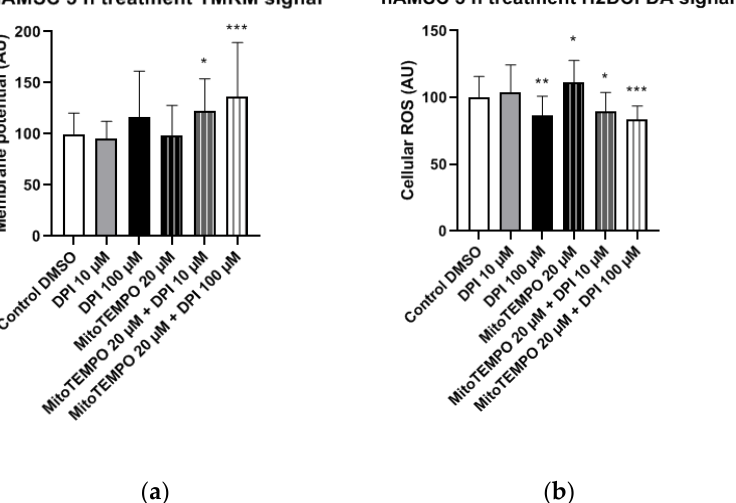
Figure 8. Mitochondrial membrane potential and cellular ROS levels 3 h after the treatment of hAMSCs with diphenyleneiodonium chloride (DPI) and MitoTEMPO. ( a ) Changes in mitochondrial membrane potential. ( b ) Changes of cellular ROS levels; high concentrations of DPI induce an increase of the ROS via the mitochondrial effects. Data is represented as means + SD (error bars) ( n = 23; each point was obtained by analyzing 2–4 single cells. * p < 0.05, ** p < 0.01, and *** p < 0.001; one-way ANOVA followed by multiple comparison post-hoc Fisher’s LSD test.